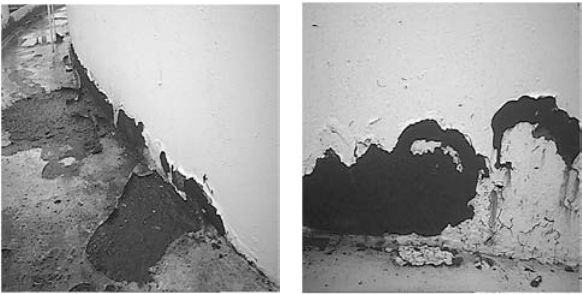
Fig. 2. Photographs of corrosive changes in belt of tank side surface on the level of wind bracing (visible areas of general not uniform